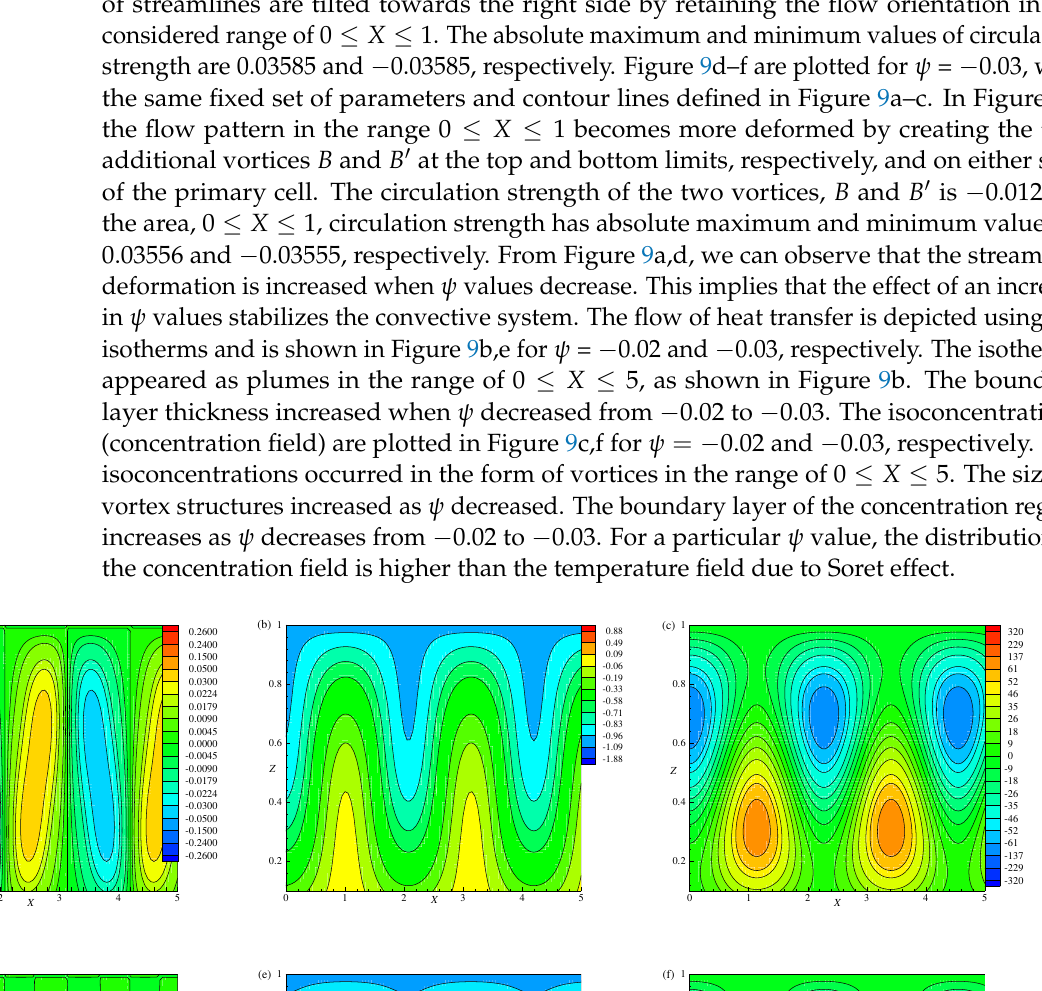
Figure 9. Streamlines ( left ), isotherms ( middle ) and isoconcentration lines ( right ) for ψ = − 0.02 ( a – c ) and − 0.03 ( d – f ) with Le = 0.06, χ = 0.4, t = 0.1, R = 3 R co . The distributions of velocity, temperature and concentration fields are plotted in Figure 10a–f for distinct values of Le with R = 3 R co , ψ = − 0.01, χ = 0.4 and t = 0.1. In Figure 10a, the streamlines are plotted for Le = 0.05. In the range of 0 ≤ X ≤ 1 the basic primary cell has been deformed and two new vortices, namely, B and B (cid:48) , are generated at the top left and right bottoms, respectively, of the basic primary cell with a circulation strength of − 0.027. The absolute maximum circulation strength of the basic cell, namely A, is 0.036. In Figure 10d, the streamlines are plotted for the decreased value of Le i.e., Le = 0.04, with the same parameters defined to plot the contour lines as shown in Figure 10a. The generated two vortices, namely, B and B (cid:48) in Figure 10a become enlarged with the increased circulation strength of − 0.006, as shown in Figure 10d. The primary cell is split into